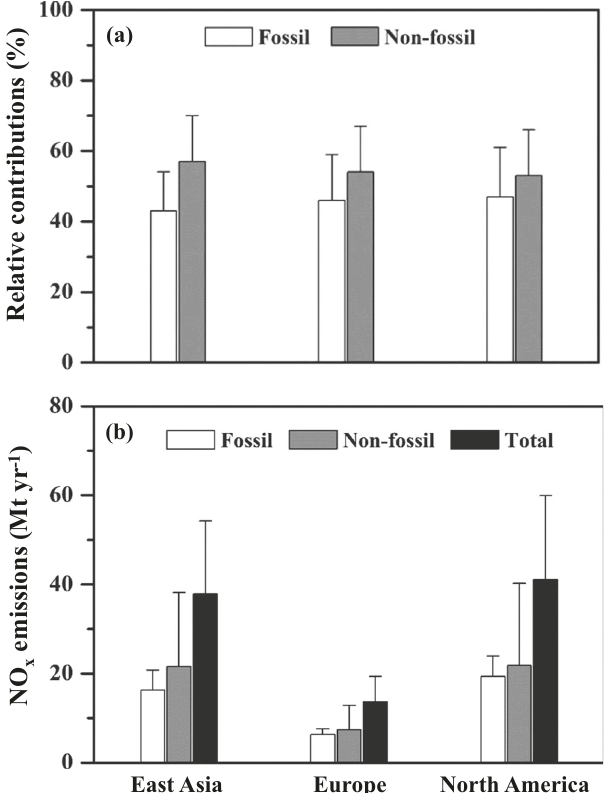
Fig. 4 Fossil and non-fossil fuel NO x emissions in East Asia, Europe, and North America. a Relative contributions. b Emission amounts. Mean± SD values are